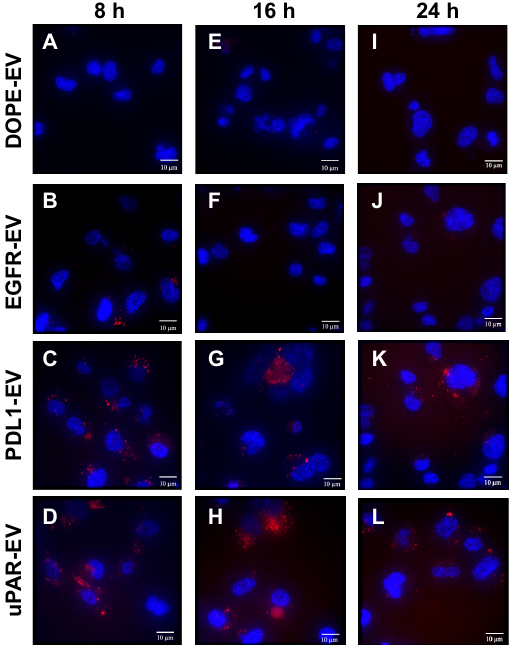
Figure 5. Fluorescence analysis of THP-engineered PalmReNL-EV uptake by MDA-MB-231 cells. MDA-MB-231 cells cultured with PalmReNL-EVs bearing DOPE-lipid nanoprobes only ( A , E , I ), EGFR- ( B , F , J ), PDL1- ( C , G , K ), or uPAR-binding peptides ( D , H , L ) for 8, 16, and 24 h. Punctate fluorescence signals of tdTomato (red) were merged with nuclei stained with Hoechst 33342 (blue). Scale bar = 10 µm.